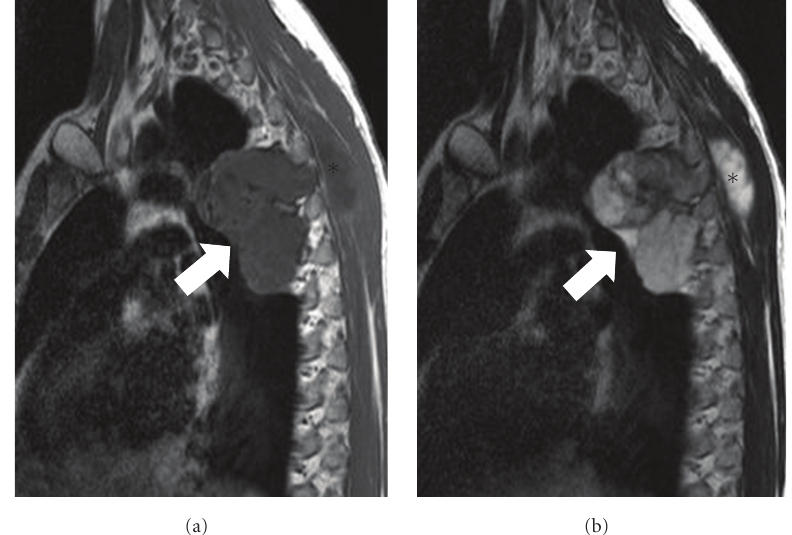
Figure 2: MR imagingof the same patient. The sagittalT1-w (a) MR image showsa hypointense lobulated lesion(arrow).(b) The sagittalT2- w MR image shows the lesion with heterogeneous but predominantly high signal intensity (arrow). Note the superficial palpable component of the tumor